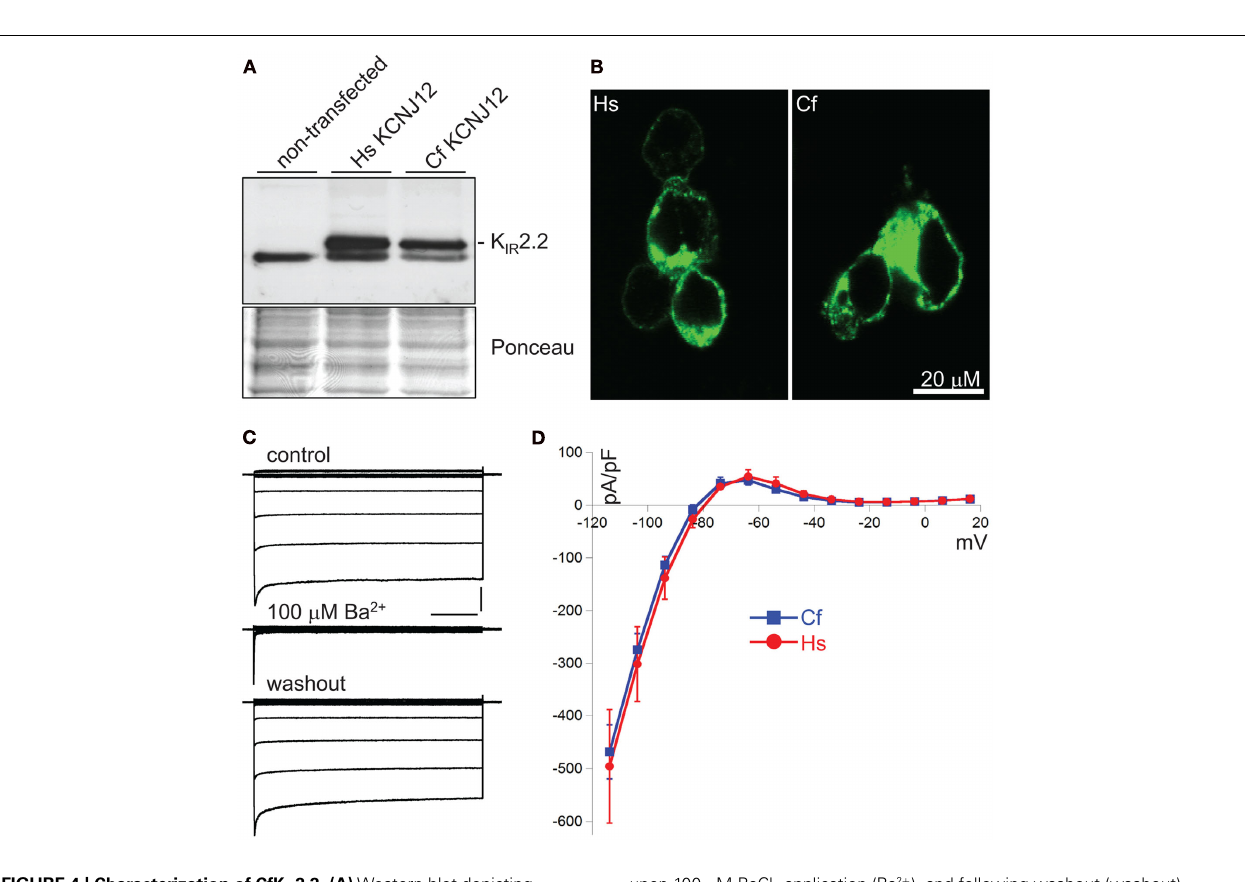
upon 100 μ M BaCl 2 application (Ba 2 + ), and following washout (washout). Horizontal bar: 200ms;Vertical bar: 2nA. (D) Current–Voltage relationship of dog (Cf, blue squares and line; n = 8, average ± SEM) and human (Hs, red circles and line; n = 4, average ± SEM) K IR 2.2 carried I K1 in HEK293T